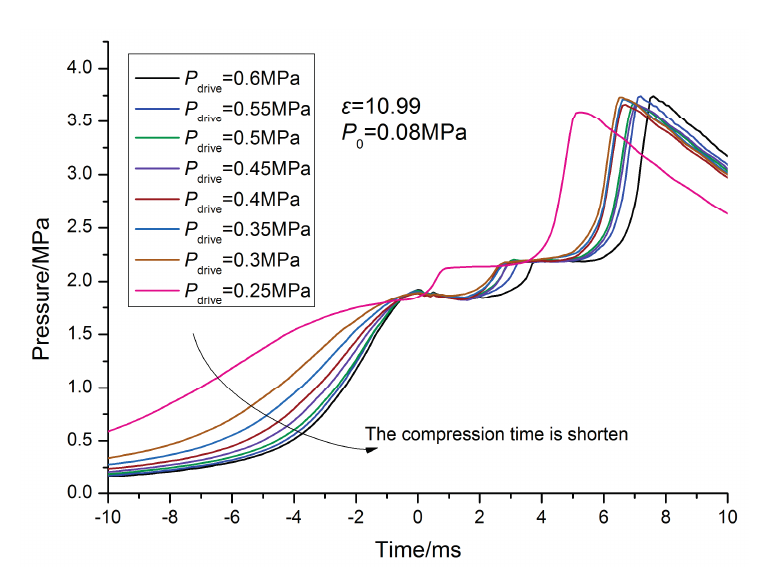
Figure 15. Effect of driving gas pressure on two-stage ignition